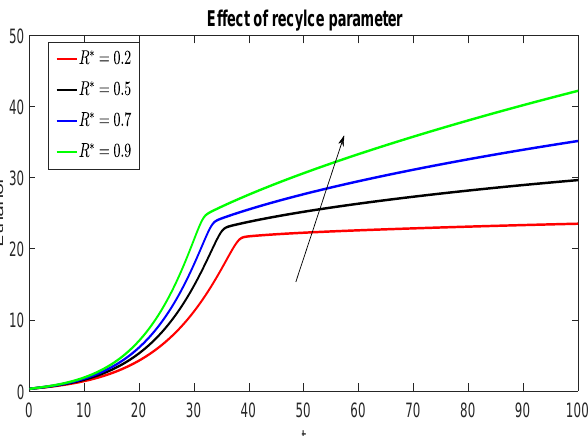
Figure 7. Effect of R ∗ on the dynamics of the model for fractional order 0.9 and fractal dimension 0.8.